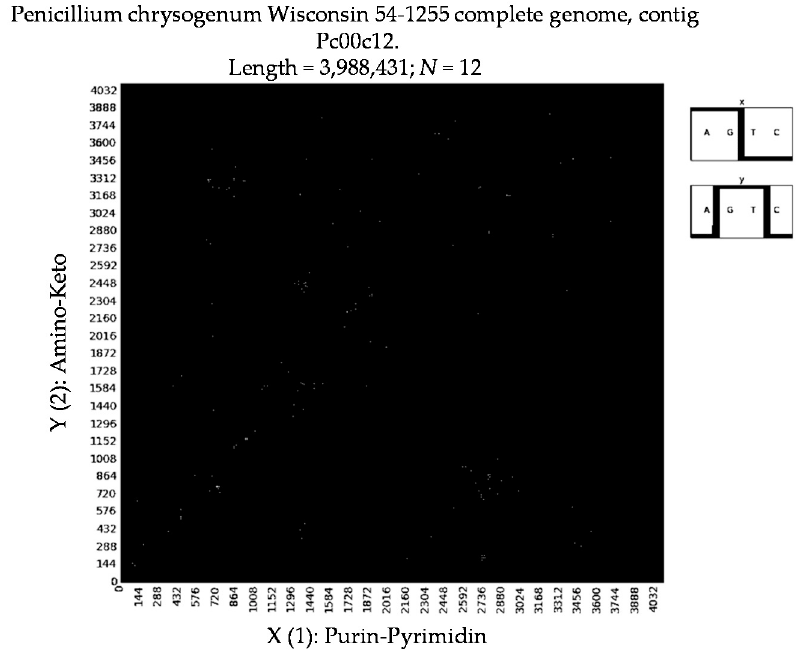
Figure 12. Examples of binary mosaics for long nucleotide sequences of different contigs of Penicillium chrysogenum Wisconsin 54-1255 complete genome. Upper level: the mosaic for the contig 22, which contains 6,387,817 nucleotides, for the case of 63-plets. The second level: the mosaic for the contig 15, which contains 535,560 nucleotides, for the case of 63-plets. The third level: the mosaic for the contig 18, which contains 1,591,038 nucleotides, for the case of 63-plets. Lower level: the mosaic for the contig 12, which contains 3,988,431 nucleotides, for the case of 12-plets. Symbols from the right side of each mosaic indicate the pair of the sub-alphabets that were used for a transformation of these N -plets into binary numbers.